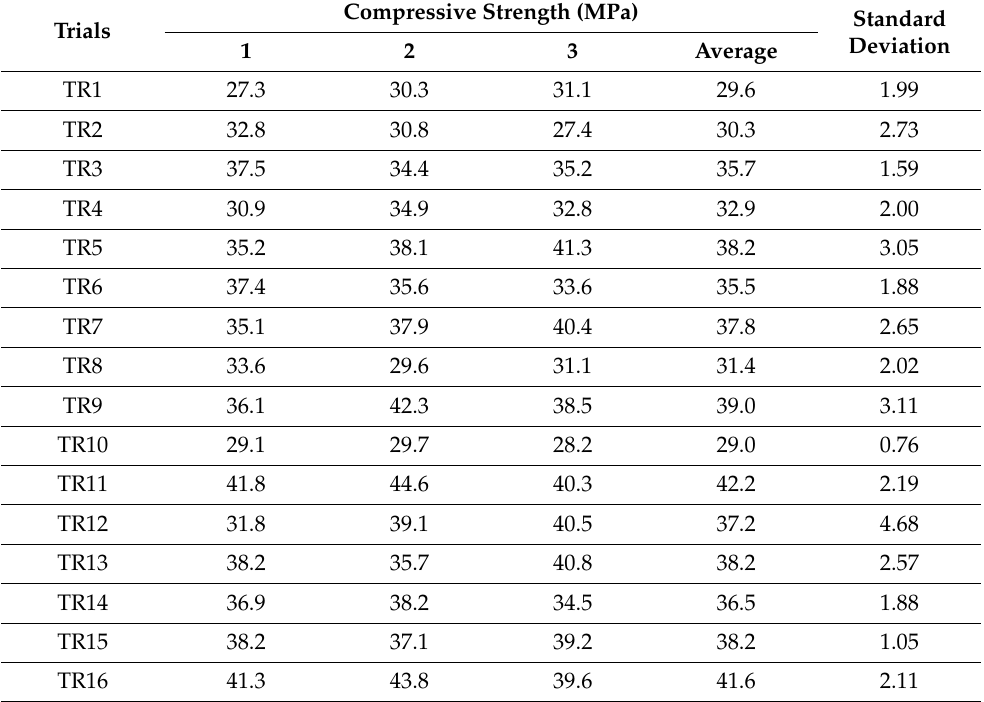
Table 6. Compressive strength